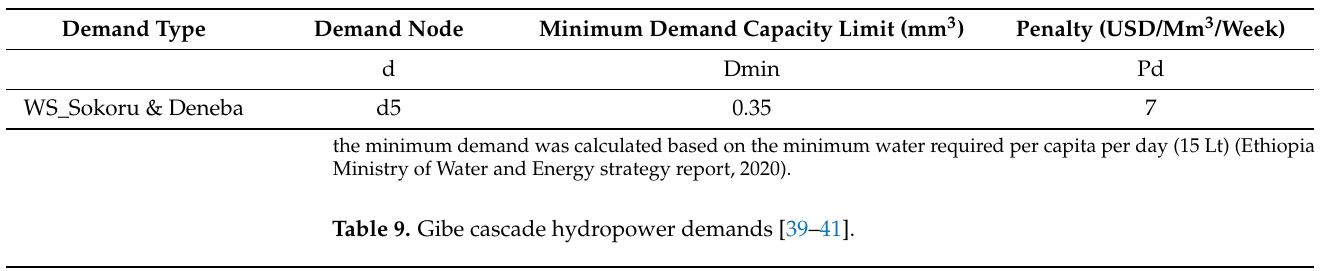
Table 8. Input data for the demand node link.